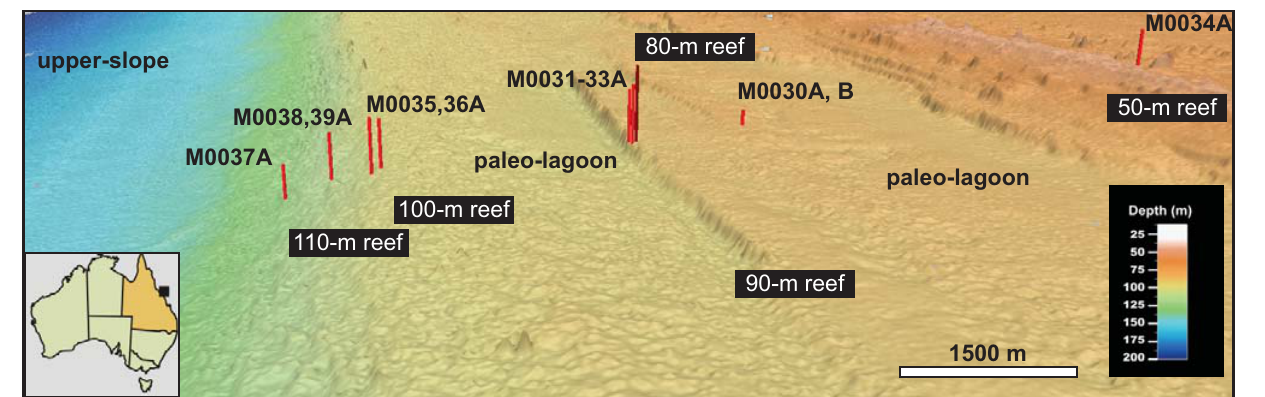
Figure 2. High-resolution multibeam image of Hydrographers Passage transect HYD-01C (multibeam data after Bridge et al., 2011; Abbey et al., submitted). The bathymetry data is gridded at 5 m, and the vertical red lines represent the positions and approximate penetration depths of sites